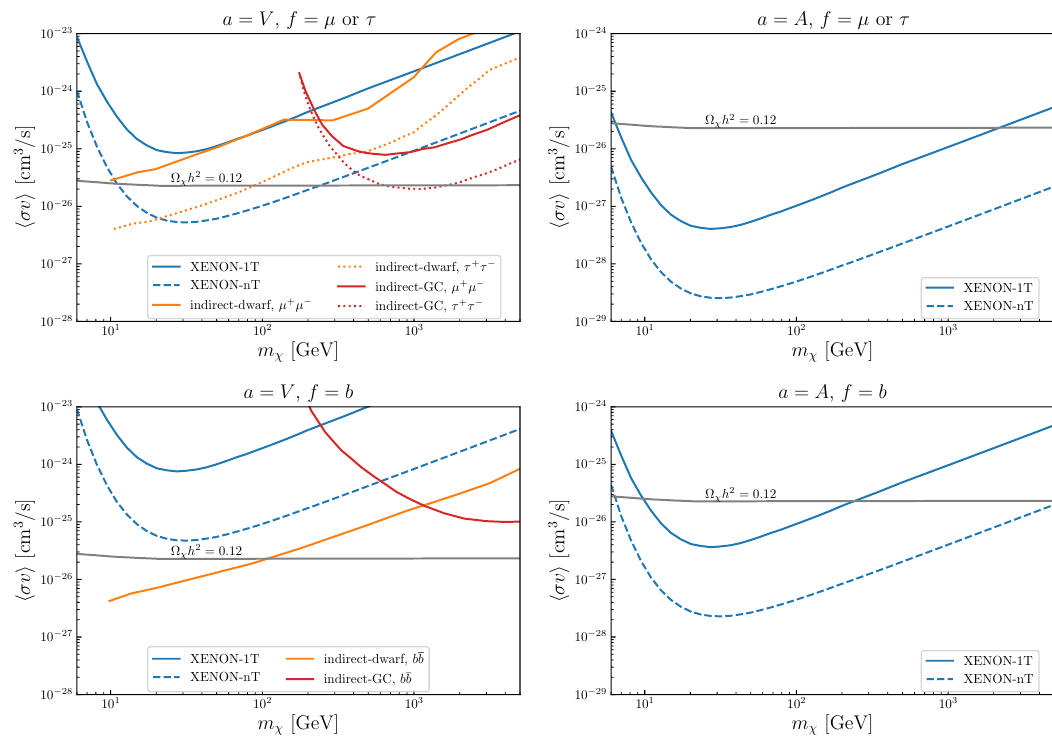
Figure 6 . Direct detection bounds on h σv i in comparison with indirect detection bounds, both obtained assuming Ω χ h 2 = 0 . 12 . For direct detection, we take the XENON-1T/nT bounds on d M obtained in figure 4 and recast them to bounds on (cid:15) ’s according to table 2, and further to bounds on h σv i according to table 1, assuming a = V / A . For indirect detections, the “indirect-dwarf” bounds are taken from ref. [61], and “indirect-GC” from [62], assuming that DM annihilates to τ + τ − , µ + µ − or bb . The horizontal line shows the thermal cross section